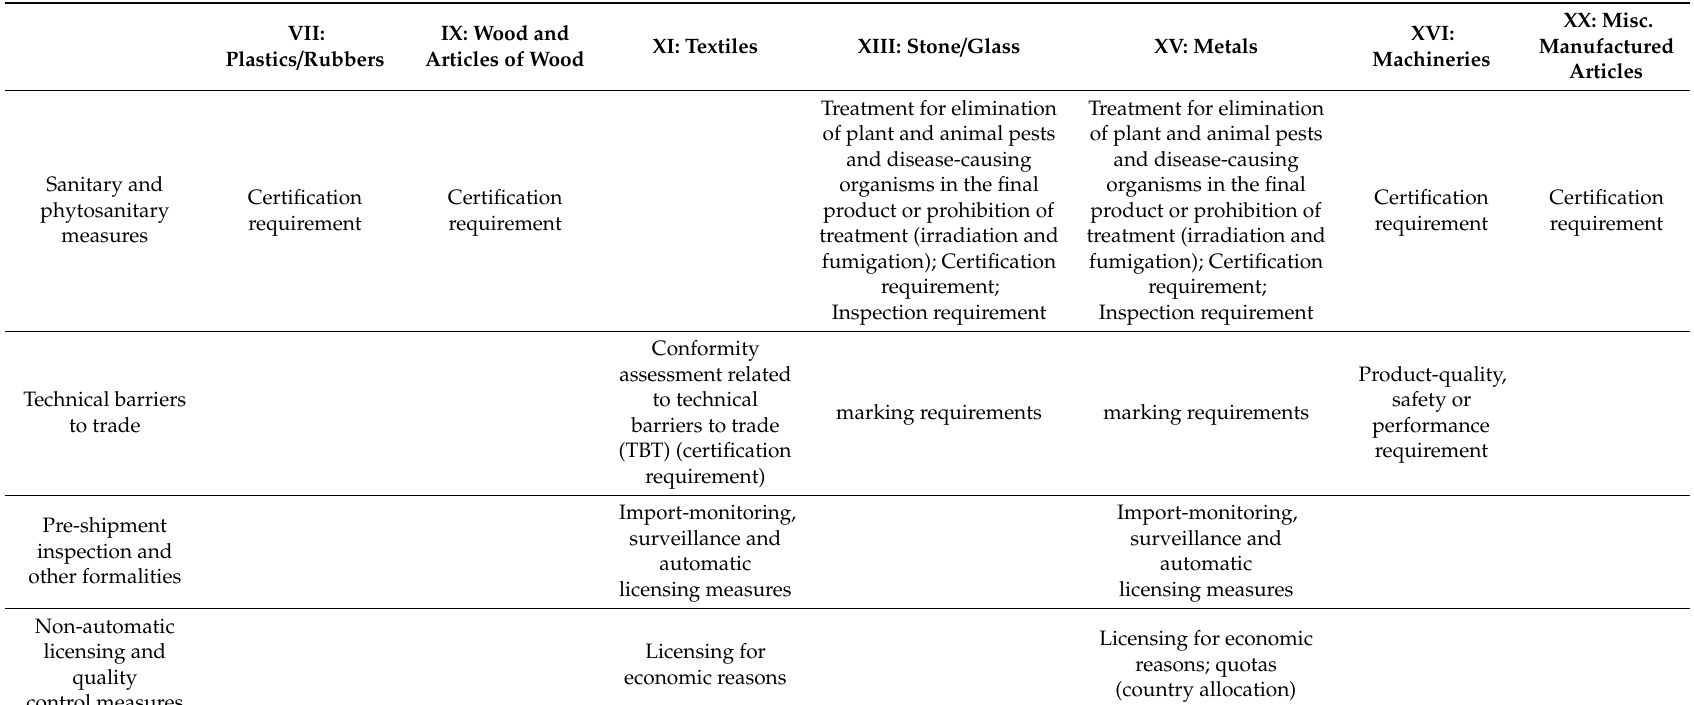
Table 2. Non-tari ff barriers (NTBs) applied by the EU (year